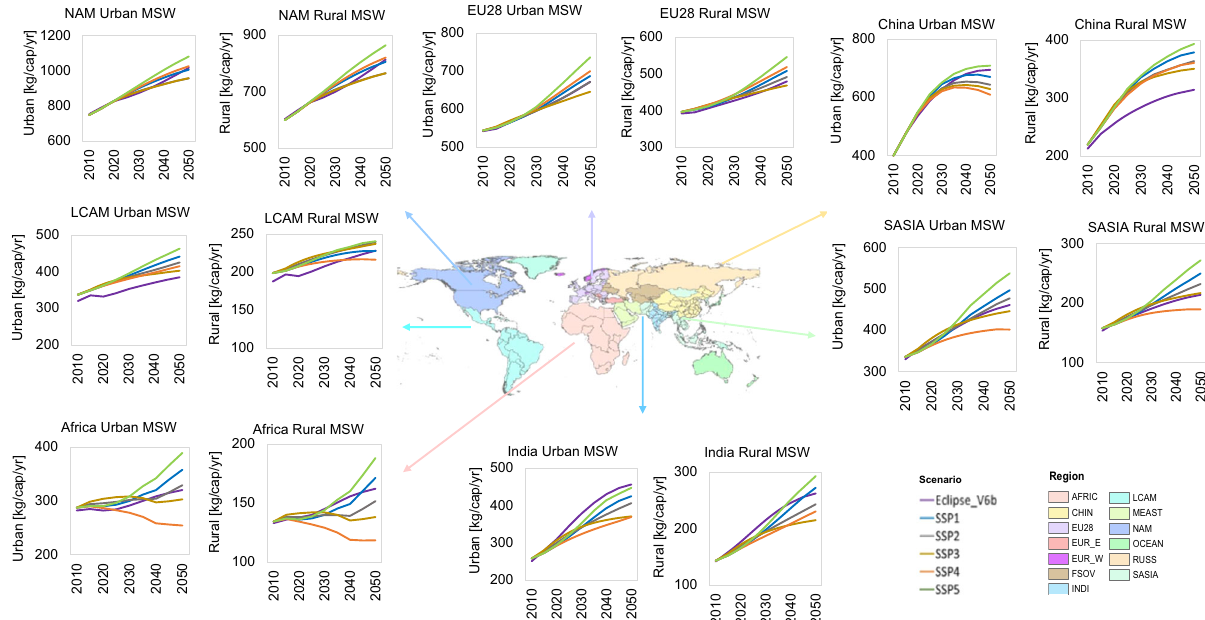
Fig. 2 Municipal solid waste generation rates in urban and rural areas. Variations in socioeconomic assumptions result in different municipal solid waste (MSW) trajectories. High-income regions such as North America (NAM) and EU28 are projected to have the highest MSW per capita and year, independent of the underlying socio-economic pathway. However, the different pathway trajectories have a strong in fl uence on MSW per capita generation in low, and middle-income regions such as Africa, Latin America (LCAM) and South Asia